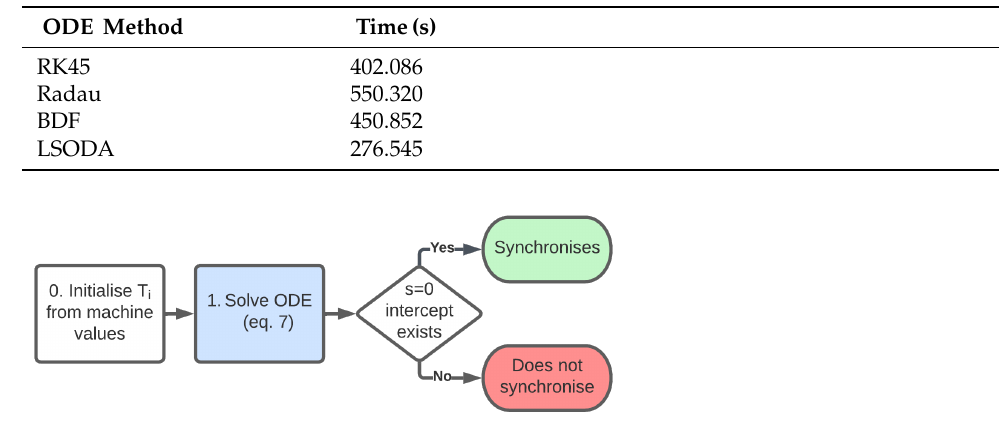
Table 4. Computational time to determine x cr using the energy method (Chama et al.) with different ODE solvers.